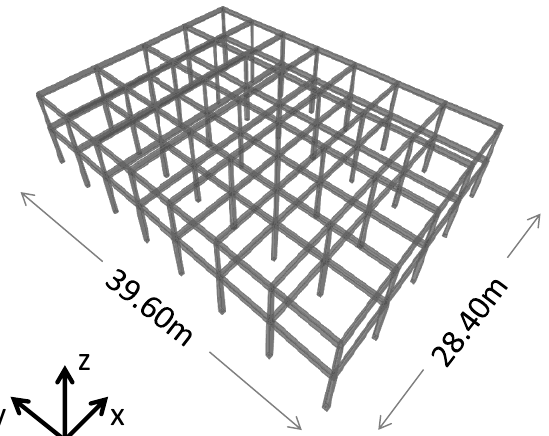
Figure 1. Description of the investigated building constructed in Zagliveri in 1979.